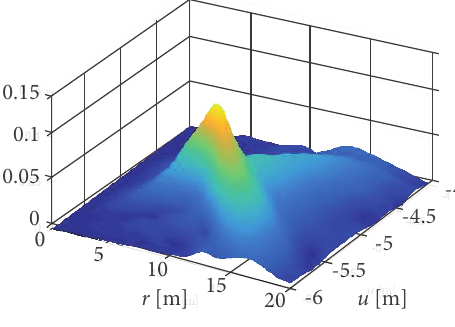
Figure 17. Nearest target actual